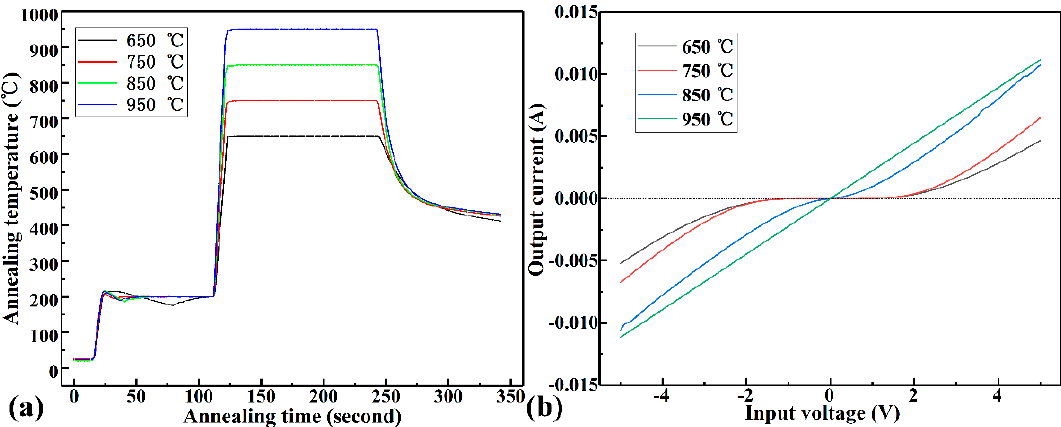
Figure 5. Ohmic contact test of SiC. ( a ) Annealing time–temperature curve. ( b ) The relationship between voltage and current at both ends of the resistor under different annealing conditions.